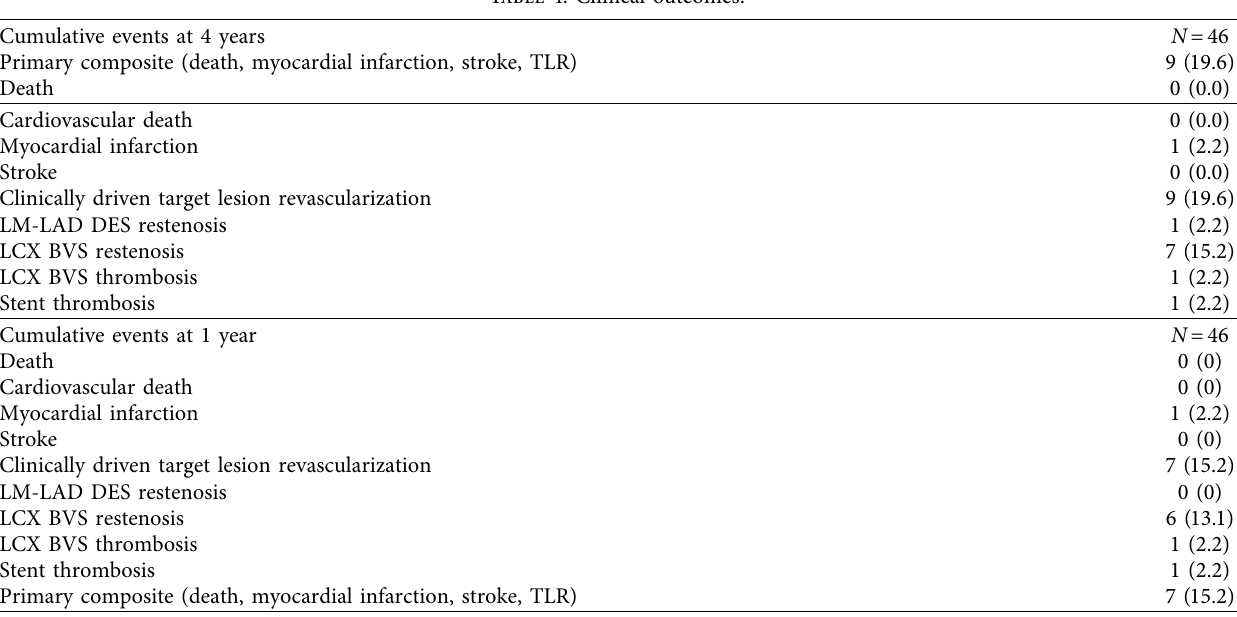
Table 4: Clinical outcomes.